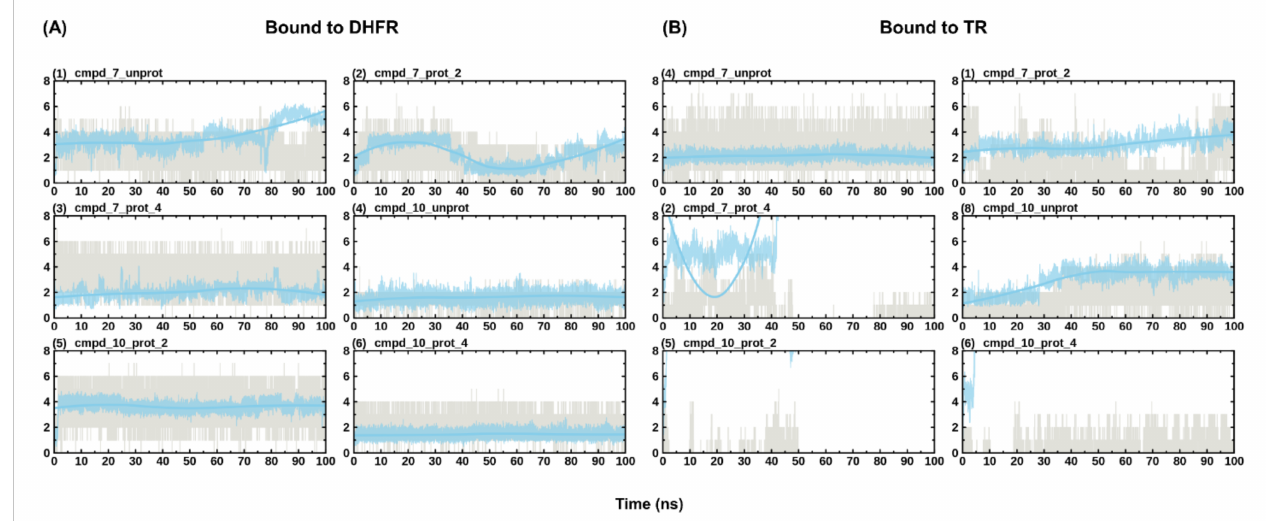
Figure 4. Evolution of ligand RMSD with respect to protein and hydrogen bond numbers during simulation. ( A ) shows the evolution of the different protonation states of the compounds in DHFR. ( B ) shows the evolution of the different protonation states of the compounds in TR. Hydrogen bond numbers are shown in grey, while the evolution of the ligand RMSD is shown in blue. RMSD values have been scaled up by a factor of 10 to fit into the scale of the hydrogen bonding numbers